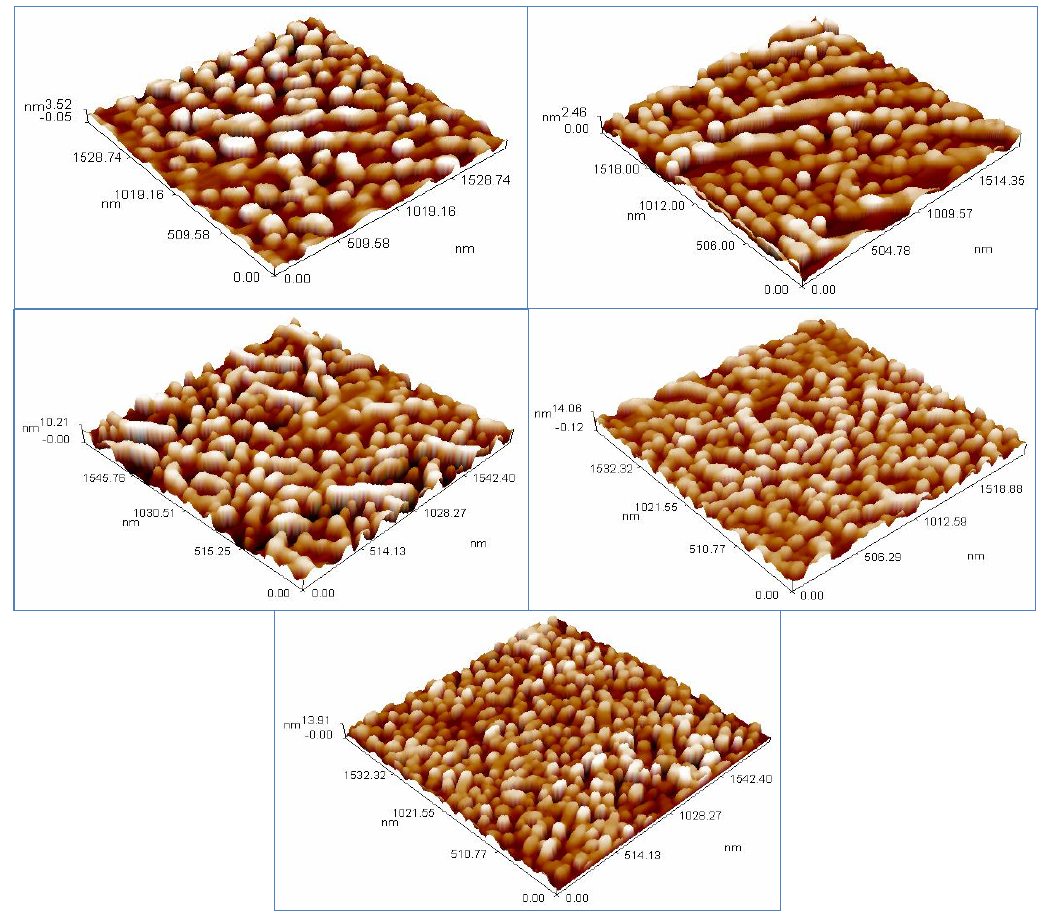
Fig.6 : AFM Images for pure and Fe-doped ZnO films (A) Pure ZnO (B) Fe-ZnO 2% (C) Fe-ZnO 4 % (D) Fe- ZnO 6% (E) Fe- ZnO 8 %. Table 1: Grain size and root mean square of surface obtained from AFM data.